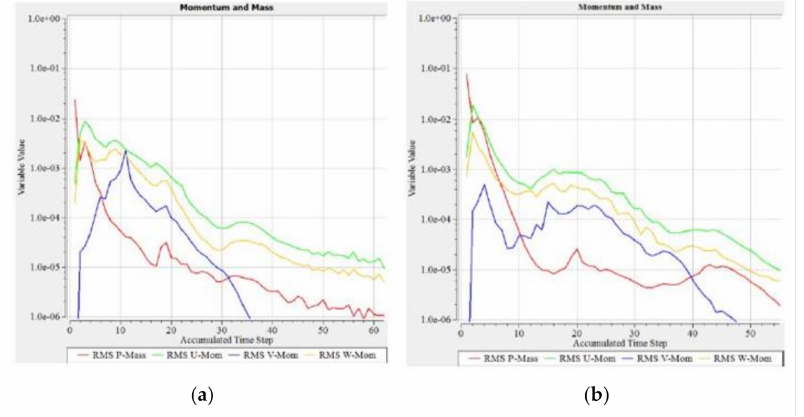
Figure 10. Convergence of momentum and mass: ( a ) Wind direction 1; ( b ) Wind direction 2.